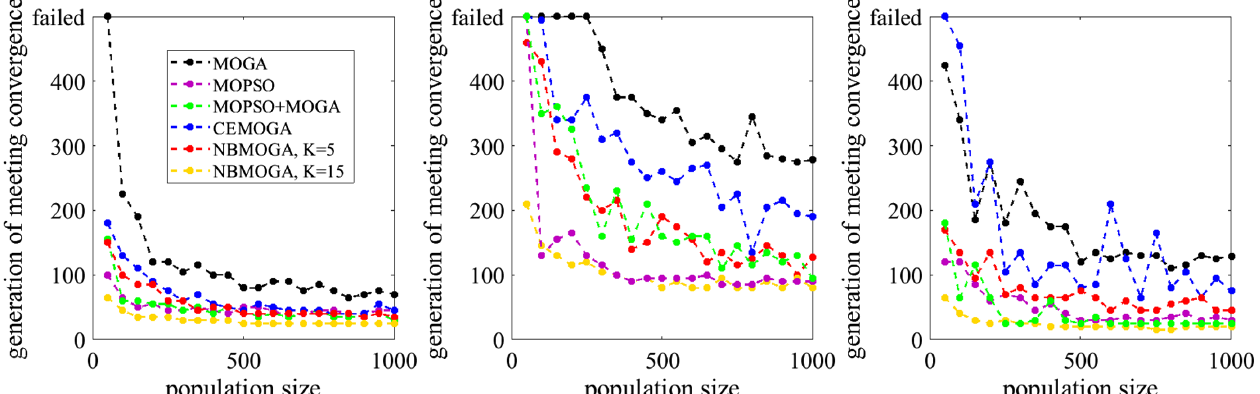
FIG. 2. Comparison of the convergence rate versus population size for the three test problems. The figures from left to right represent ZDT1, ZDT2, and ZDT6, respectively. The X axis indicates the population size, and the Y axis is the generation index when the population first reaches to the Pareto front. The “ failed ” on the Y axis indicates the failure of reaching the Pareto front after 500 generations of optimization. The black, purple, green, blue, red, and yellow points represent the results obtained with the standard MOGA, MOPSO, combination of MOPSO and MOGA, CEMOGA, NBMOGA ( K ¼ 5 ), and NBMOGA ( K ¼ 15 ),